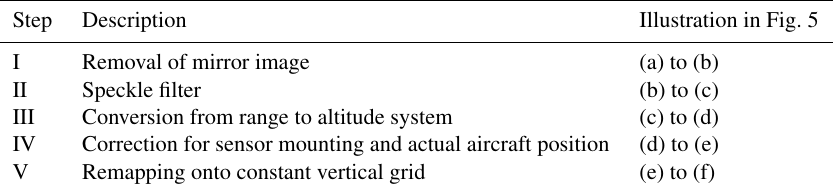
Table 3. Processing steps for MiRAC-A radar measurements